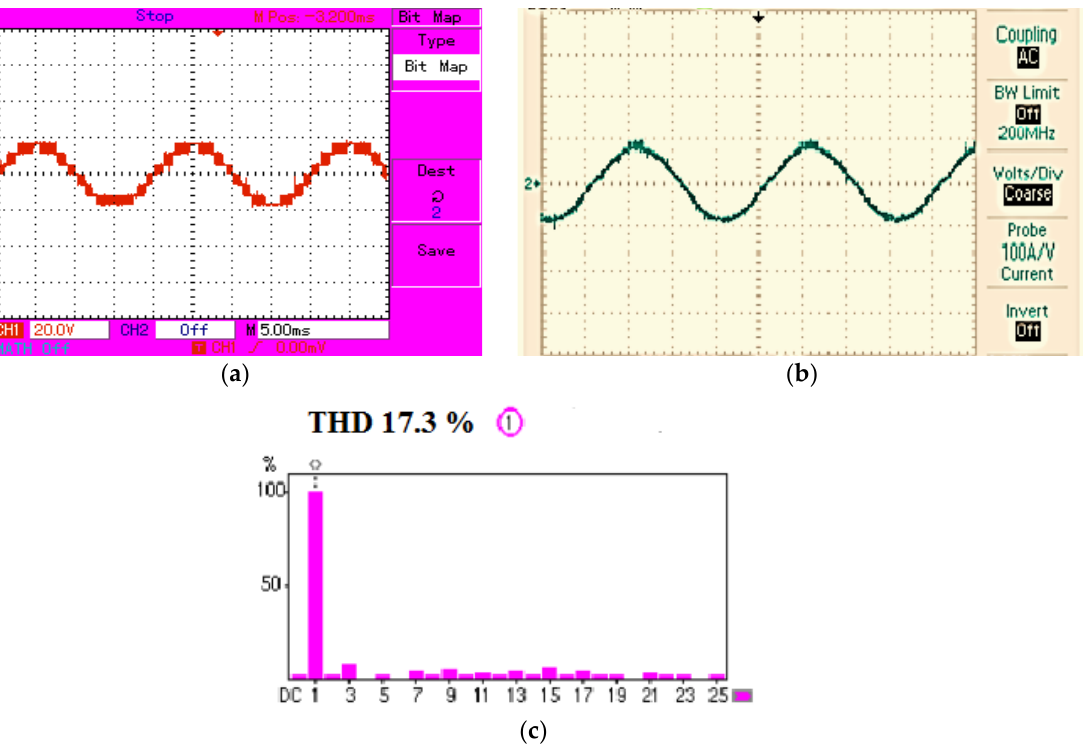
Figure 20. Experimental output waveform for the VFPWM strategy. ( a ) Voltage; ( b ) Current; ( c ) FFT